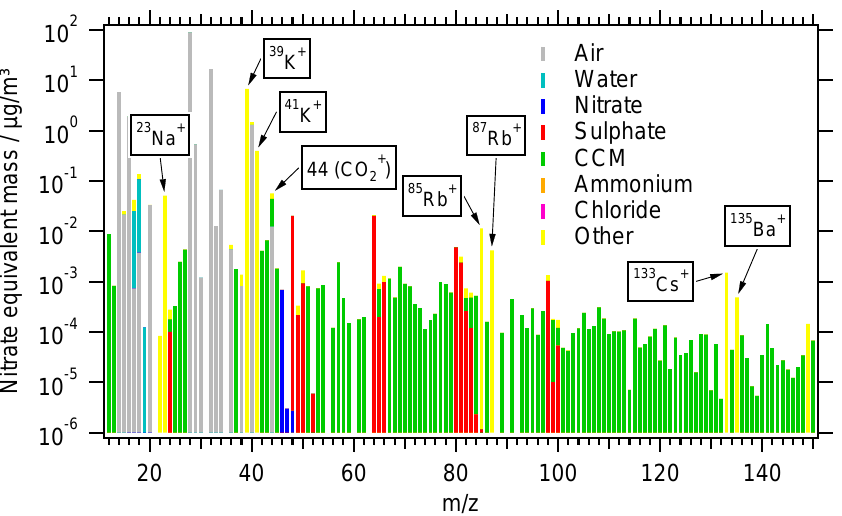
Fig. 2c. Average AMS mass spectrum of sulphuric acid processed ATD during the FROST2 campaign. The sulphuric acid bath temperature was 70 ◦ C. Beside the sulphate peaks in red, the metal peaks that were already visible in the unprocessed 820 ◦ C data remain visible. The silicone probably reacted with the sulphuric acid and is no longer